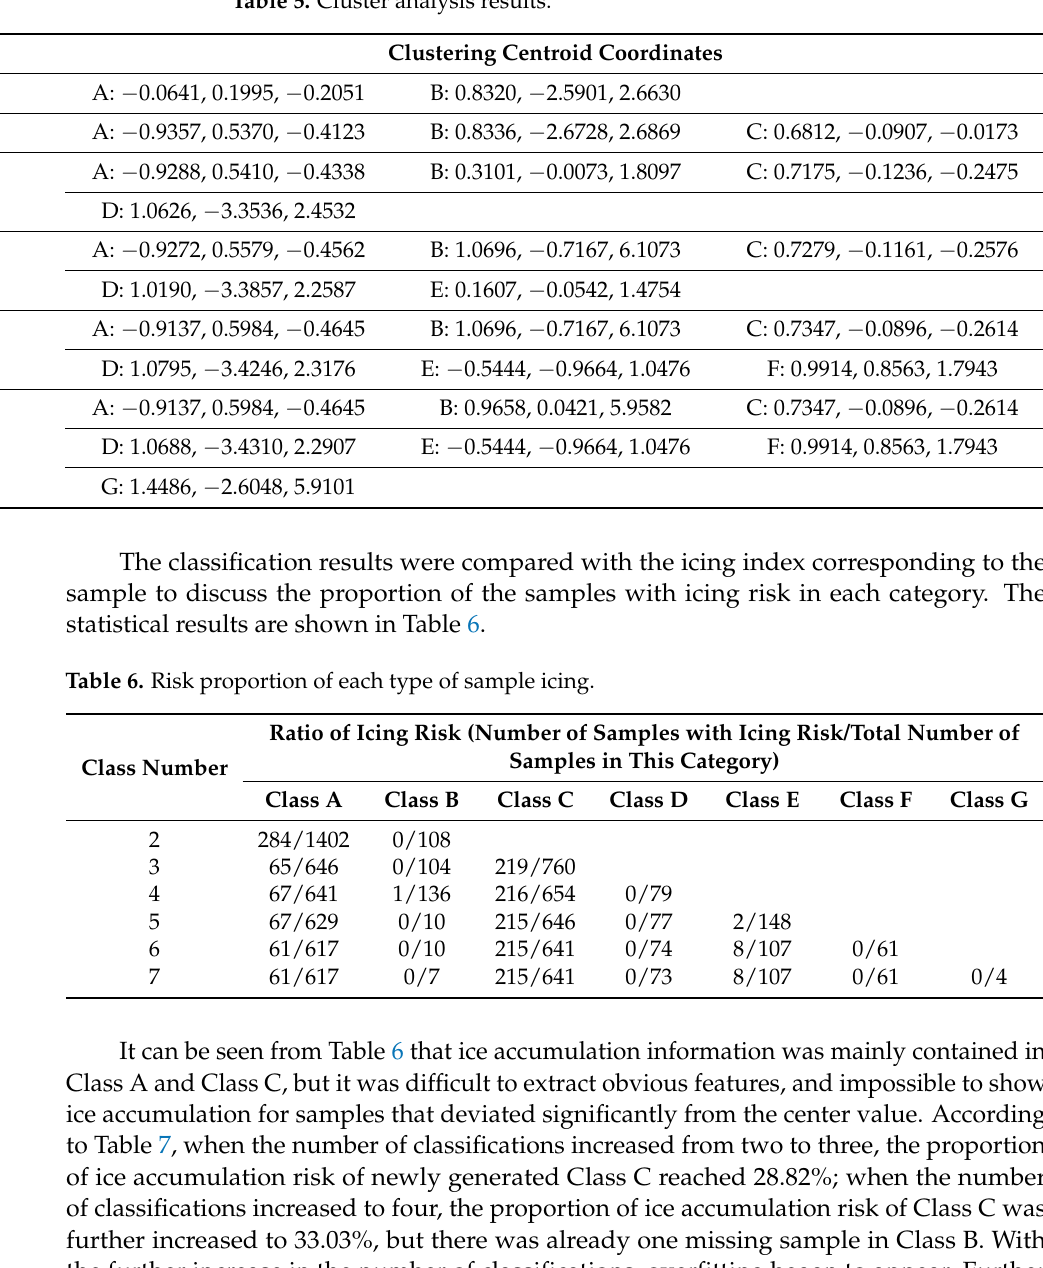
Table 5. Cluster analysis results.